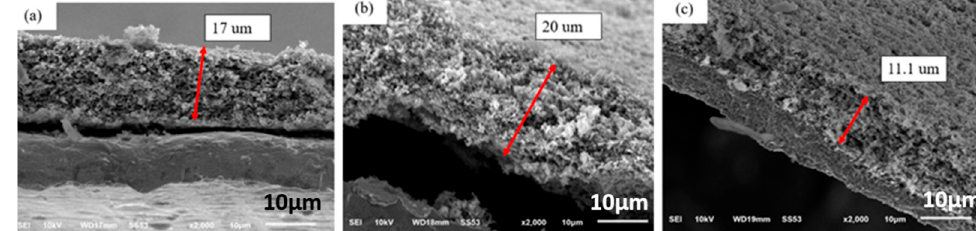
Figure 3. Cross ‐ sectional SEM images of electrodes made of silicon flake and binder of the weight ratio of 7:3. ( a ) Before pyrolysis, ( b ) After pyrolysis, ( c ) After heat treatment at 600 °C in air.